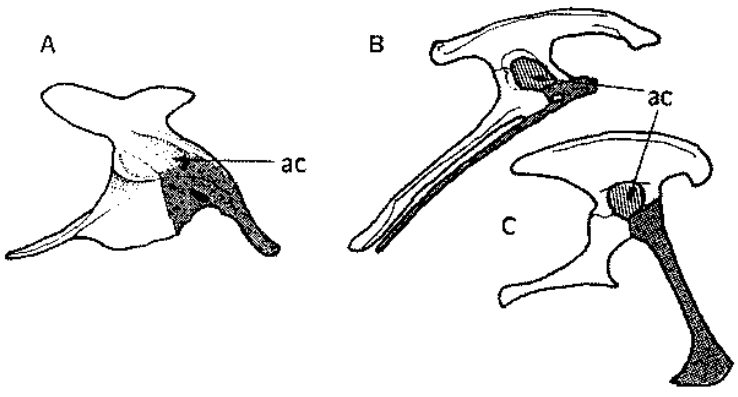
Fig. 4 – Schematic illustration of reptilian pelves in right lateral view (not to scale): A - basal archosaur; B - Ornithischia; C - Saurischia. Note that the acetabulum (ac) is closed in basal archosaurs and open in dinosaurs. The pubis (darker) is directed forward in Saurischia (a plesiomorphic condition also present in basal archosaurs), while directed backward in Ornithischia (a derived